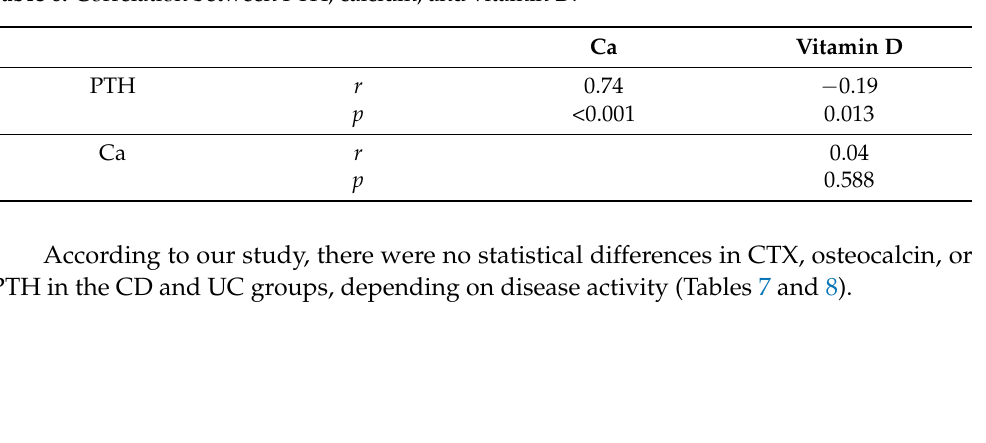
Table 6. Correlation between PTH, calcium, and vitamin D.